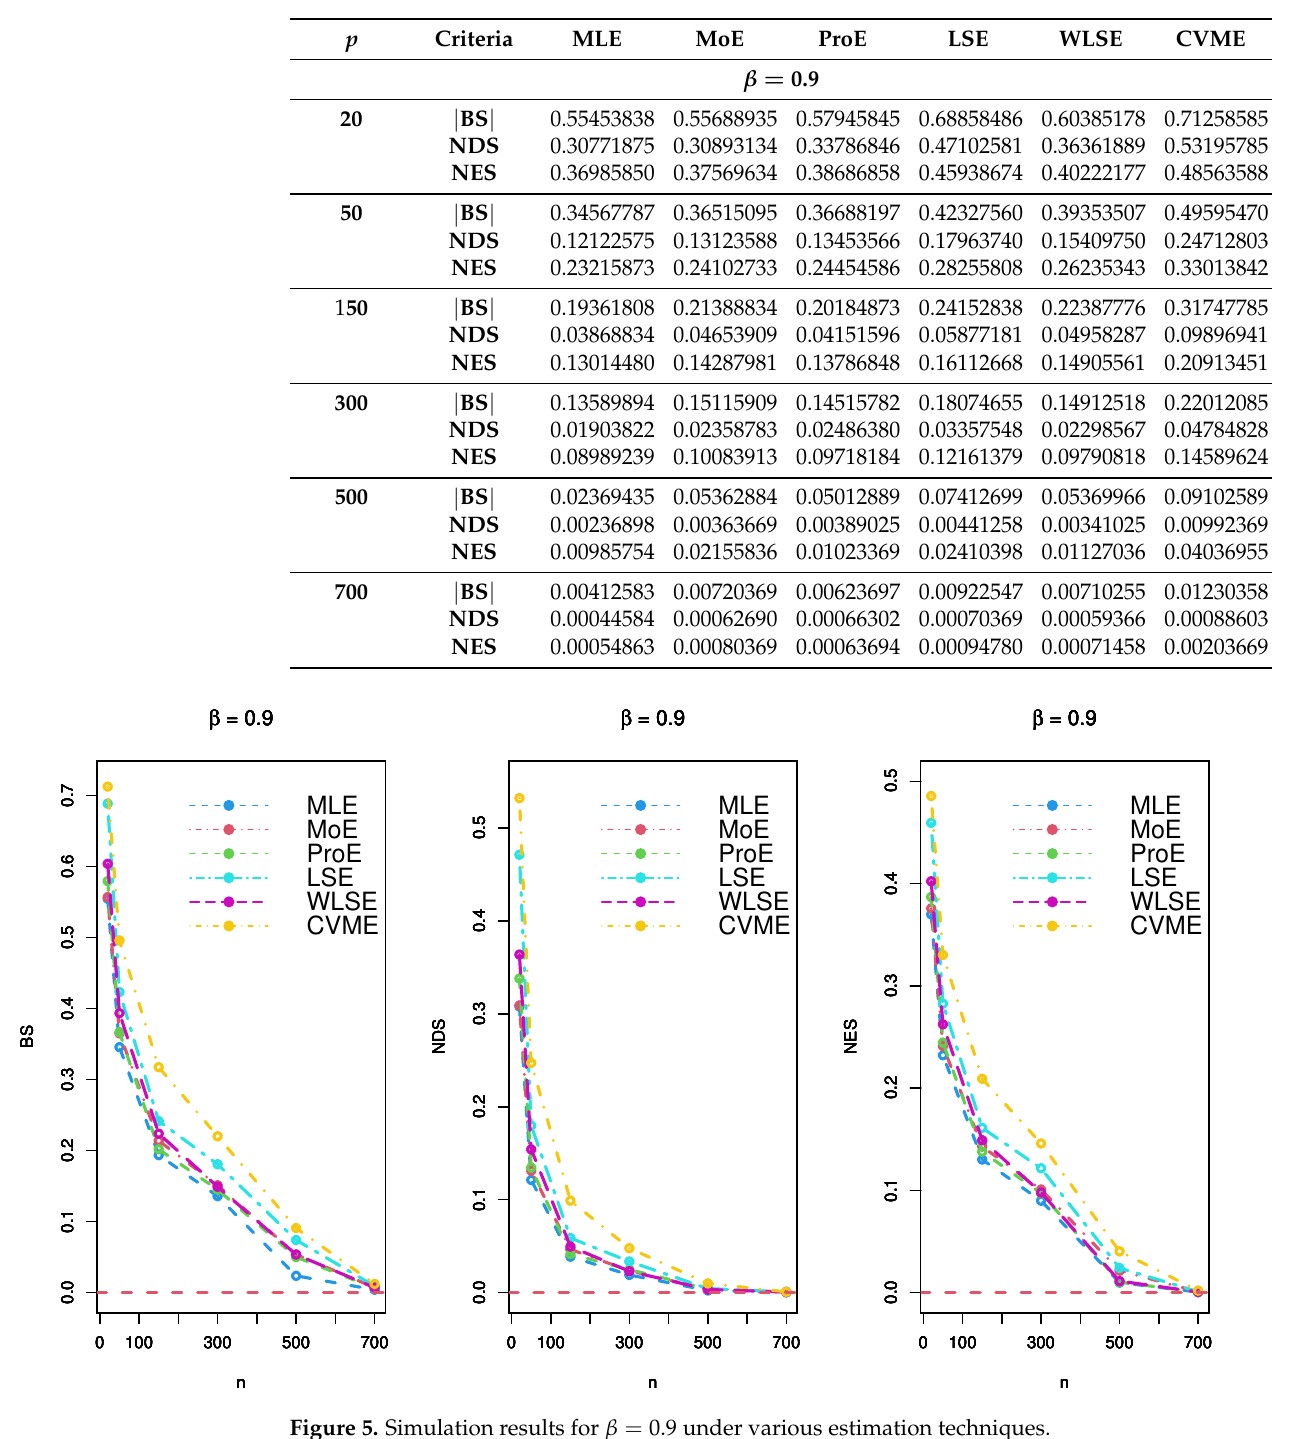
Table 4. The performance of different estimators.